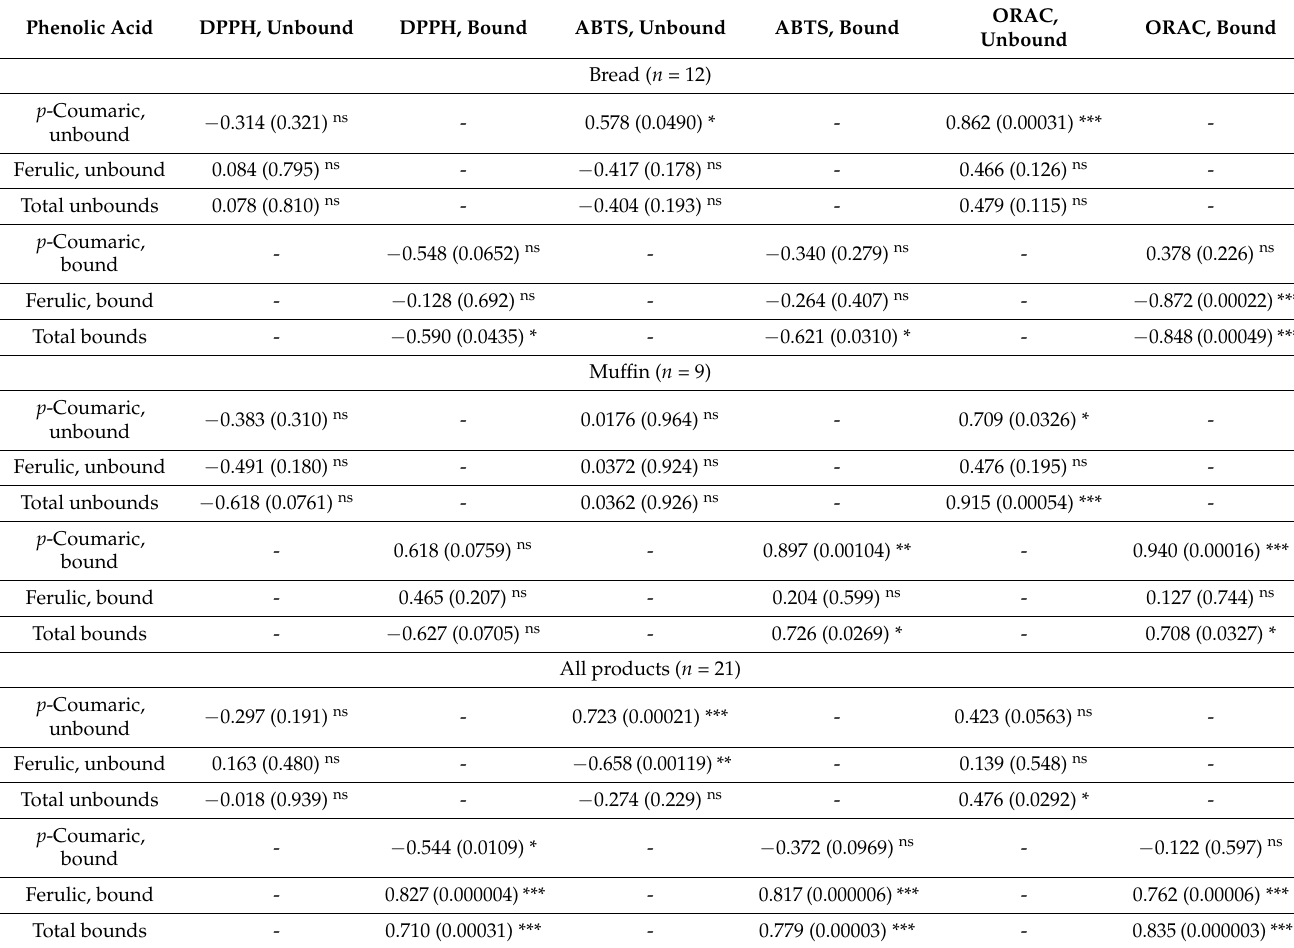
Table 6. Relationships between phenolic acids and antioxidant activity of bread and muffin